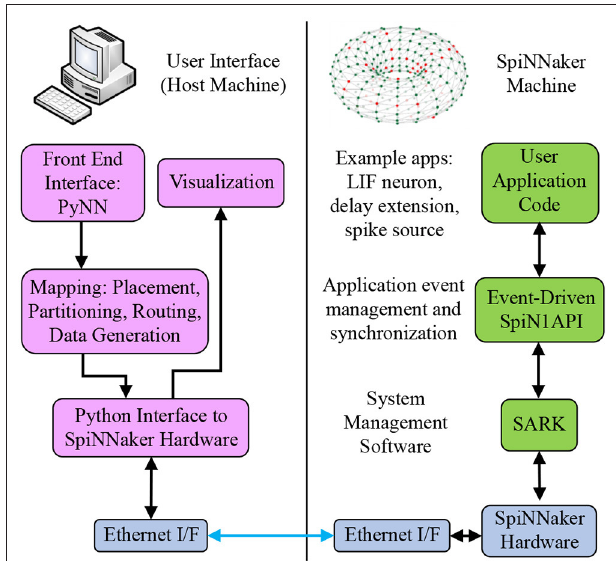
FIGURE 2 | SpiNNaker software stacks. From top left anti-clockwise to top right: users create SNN models on host via the PyNN interface; the sPyNNaker Python software stack then translates the SNN model into a form suitable for a SpiNNaker machine, and loads the appropriate data to SpiNNaker memory via Ethernet; sPyNNaker applications, built on the SARK system management and SpiN1API event-driven processing libraries, use the loaded data to perform realtime simulation of neurons and synapses.